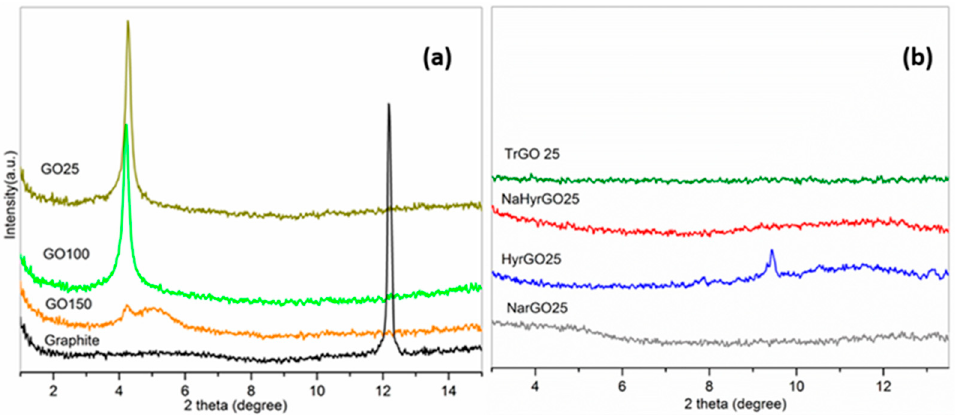
Figure 4. XRD patterns of ( a ) Graphite (at 25 °C) and GO at different temperatures (numbers indicate temperature), and ( b ) chemically and thermally reduced GOs at 25 °C.